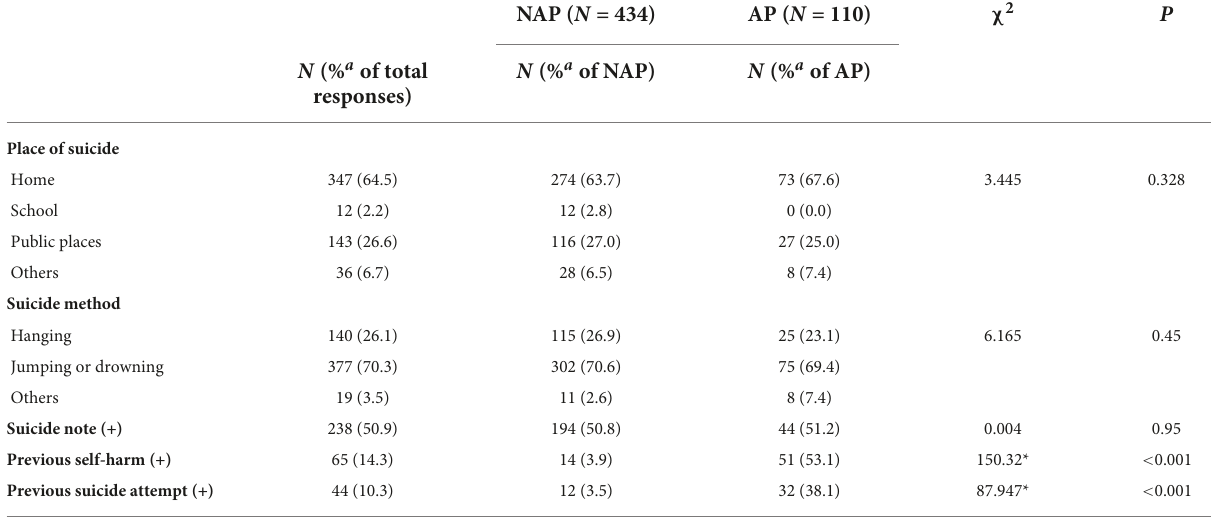
TABLE 2 Characteristics related to